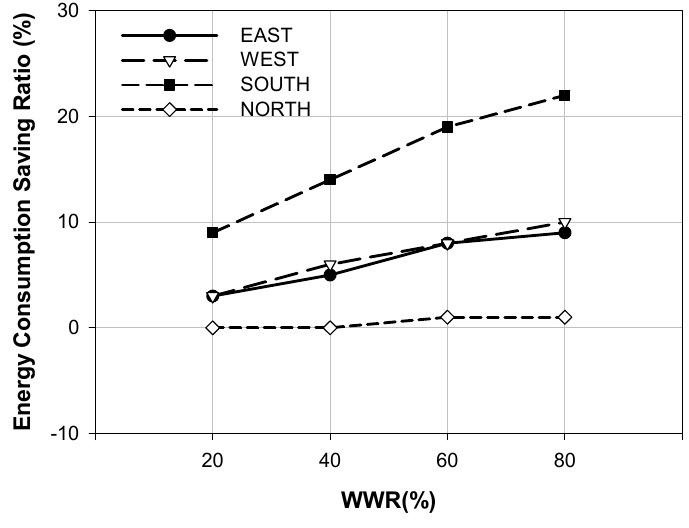
Figure 6. Energy consumption saving ratio by WWR and